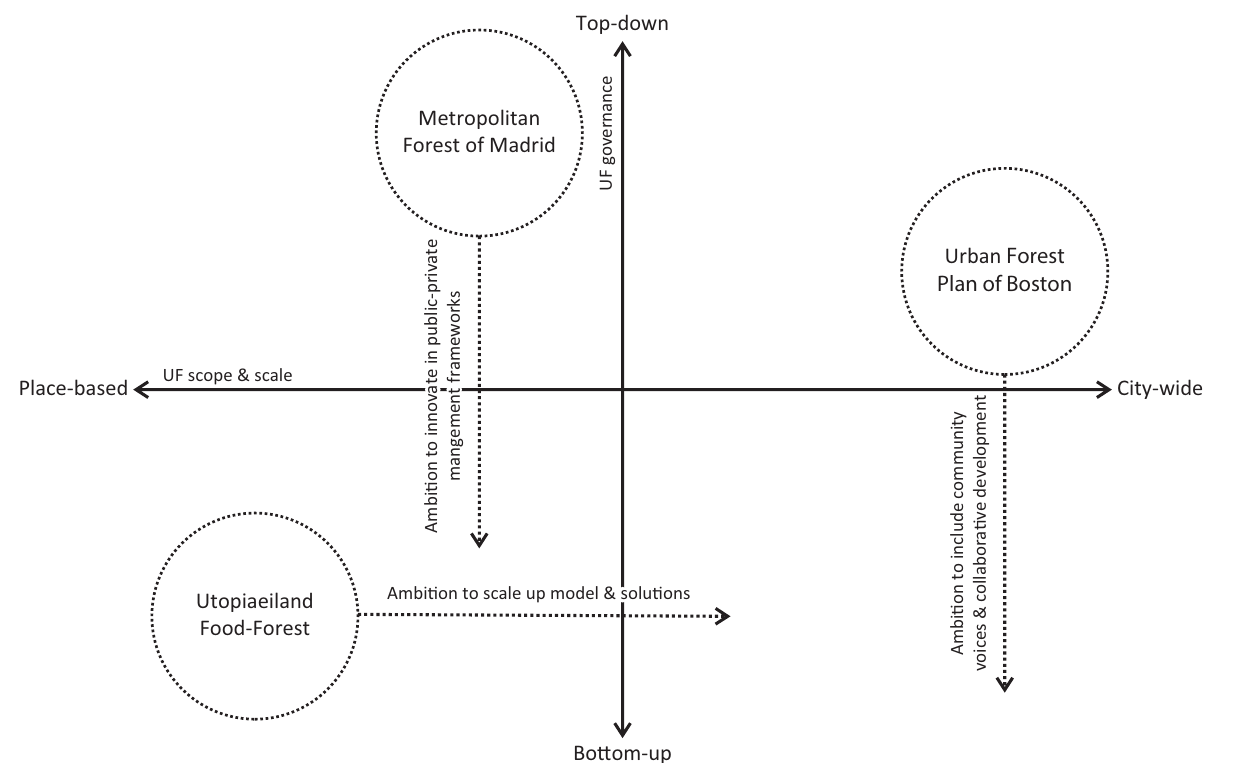
Figure 1. Position and ambition of the case studies within the top‐down/bottom‐up spectrum and range of scope and scale of the UF